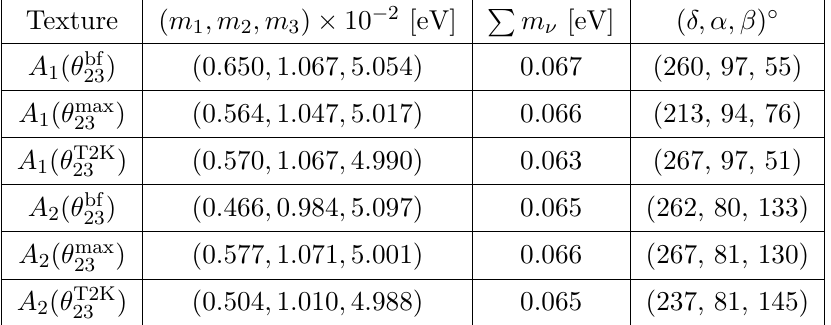
= 45 (cid:14) , and for the 23